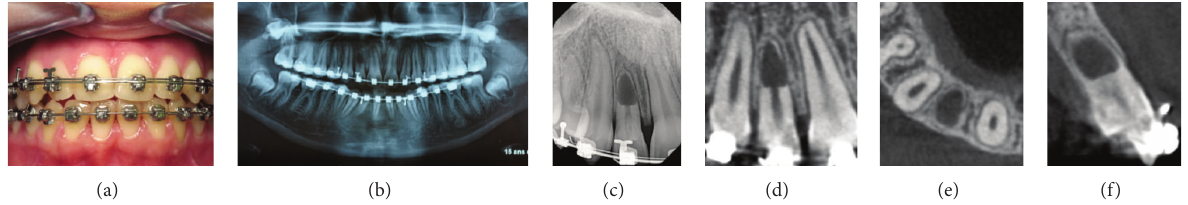
Figure 1: Diagnosis of an apical internal root resorption in a 16-year old patient at the end of orthodontic treatment (tooth 12). (a) Extraoral photograph: The clinical data of the examination are no pain, no crown discoloration, healthy periodontal probing, and thermic and electric pulp; vitality tests are positive (possibly false positive). (b) Panoramic radiograph: note the apical resorption of the right upper lateral incisor. (c) Periapical radiograph confirms the invasive internal resorption in the apical third: the canal disappears with perforation of radicular walls. However, the lamina dura is present. (d), (e), and (f) Sagittal, axial, and coronal CBCT cross-sections. The most likely etiological hypothesis is an inflammatory reaction of the pulp due to traumatic orthodontic procedures. Because of the absence of symptoms, the decision was the abstention with periodical clinic and radiographic